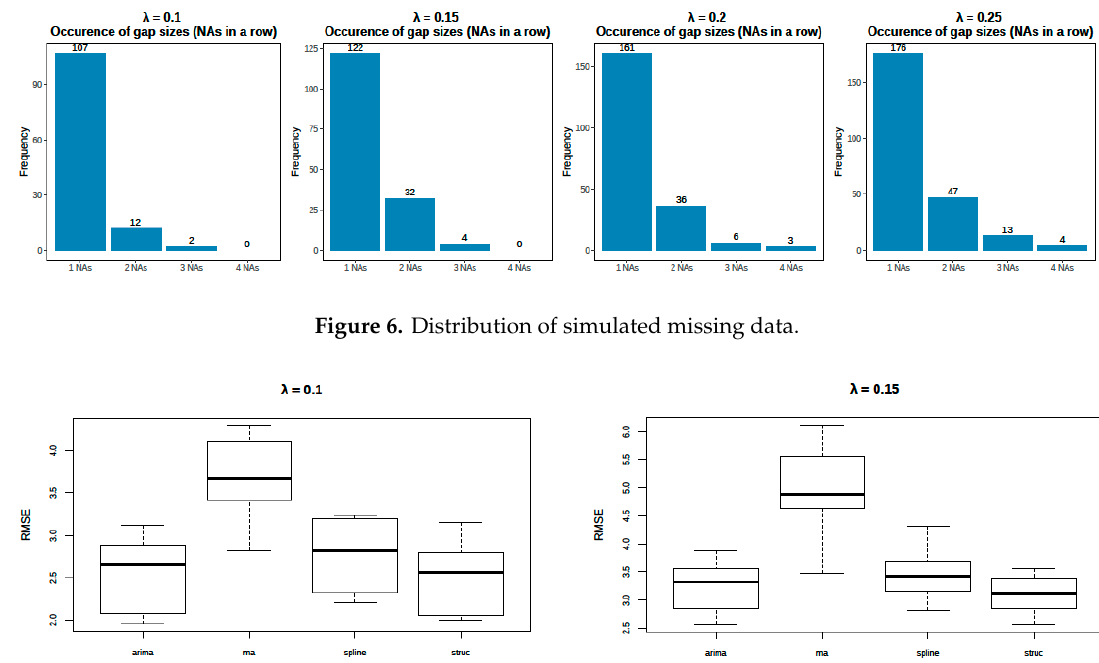
Figure 6. Distribution of simulated missing data.